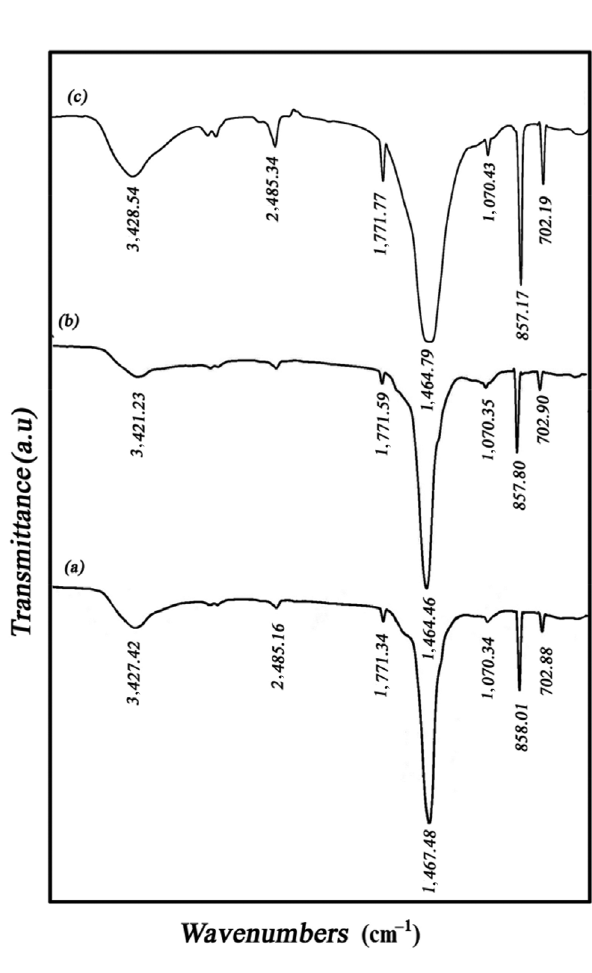
Figure 3: FT-IR of (a) sample no. 7, (b) sample no. 11 and (c) purified sample